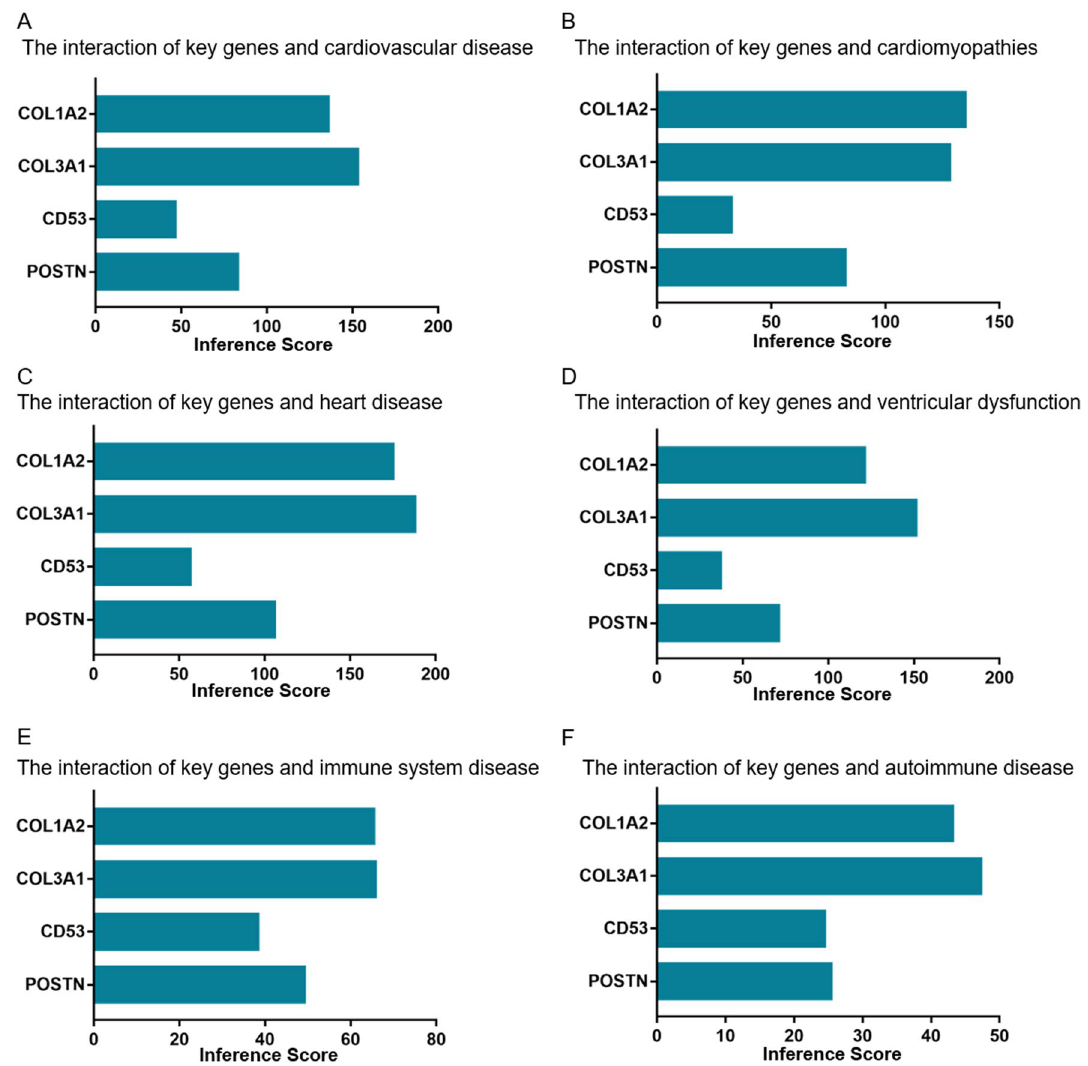
Figure 10. Relationship analysis of the four potential immune-related genes with cardiovascular and immune- related diseases in CTD. Four potential immune-related genes ( COL1A2 , COL3A1 , CD53 , and POSTN .) targeted multiple cardiovascular diseases and immune-related diseases, including ( A ) cardiovascular disease, ( B ) heart disease, ( C ) heart disease, ( D ) ventricular dysfunction, ( E ) immune system disease, ( F ) autoimmune disease, respectively. CTD: comparative toxicogenomics